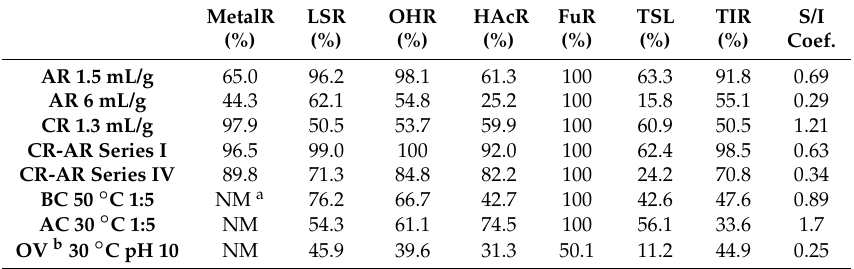
Table 3. Optimal results of detoxified-SSL applying different detoxification